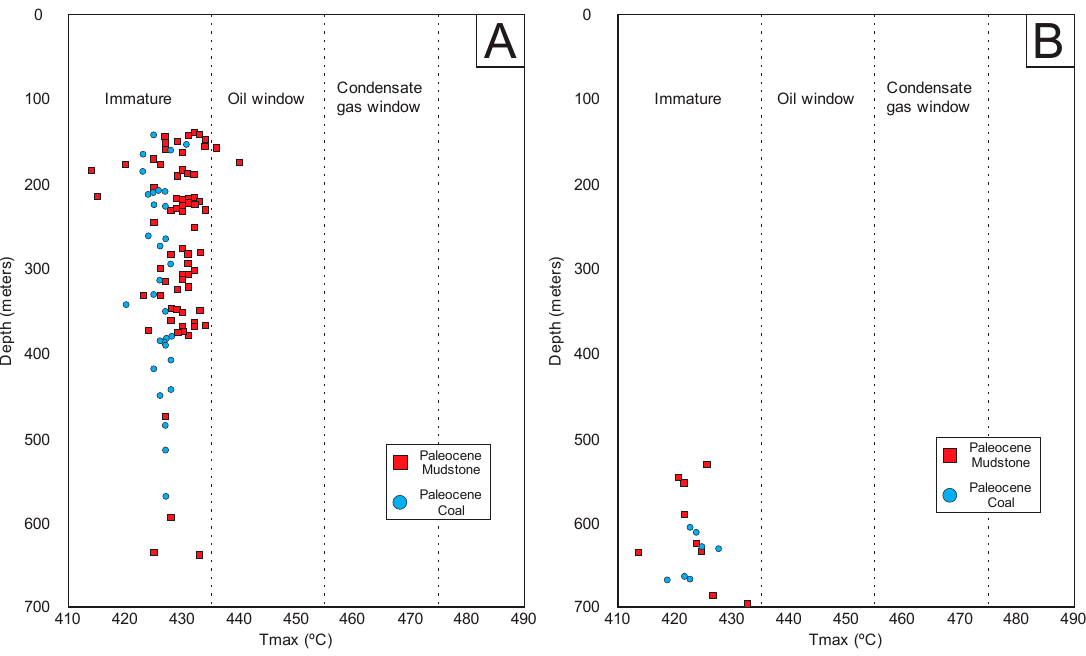
Figure 14. Cross plot of Tmax (°C) versus depths (m) to demonstrate the distribution of the parameter with increasing depth in the Cerrejón Formation of the ( A ) ANH-CARRETALITO-1 and ( B ) ANH-CAÑABOBA-1 wells.